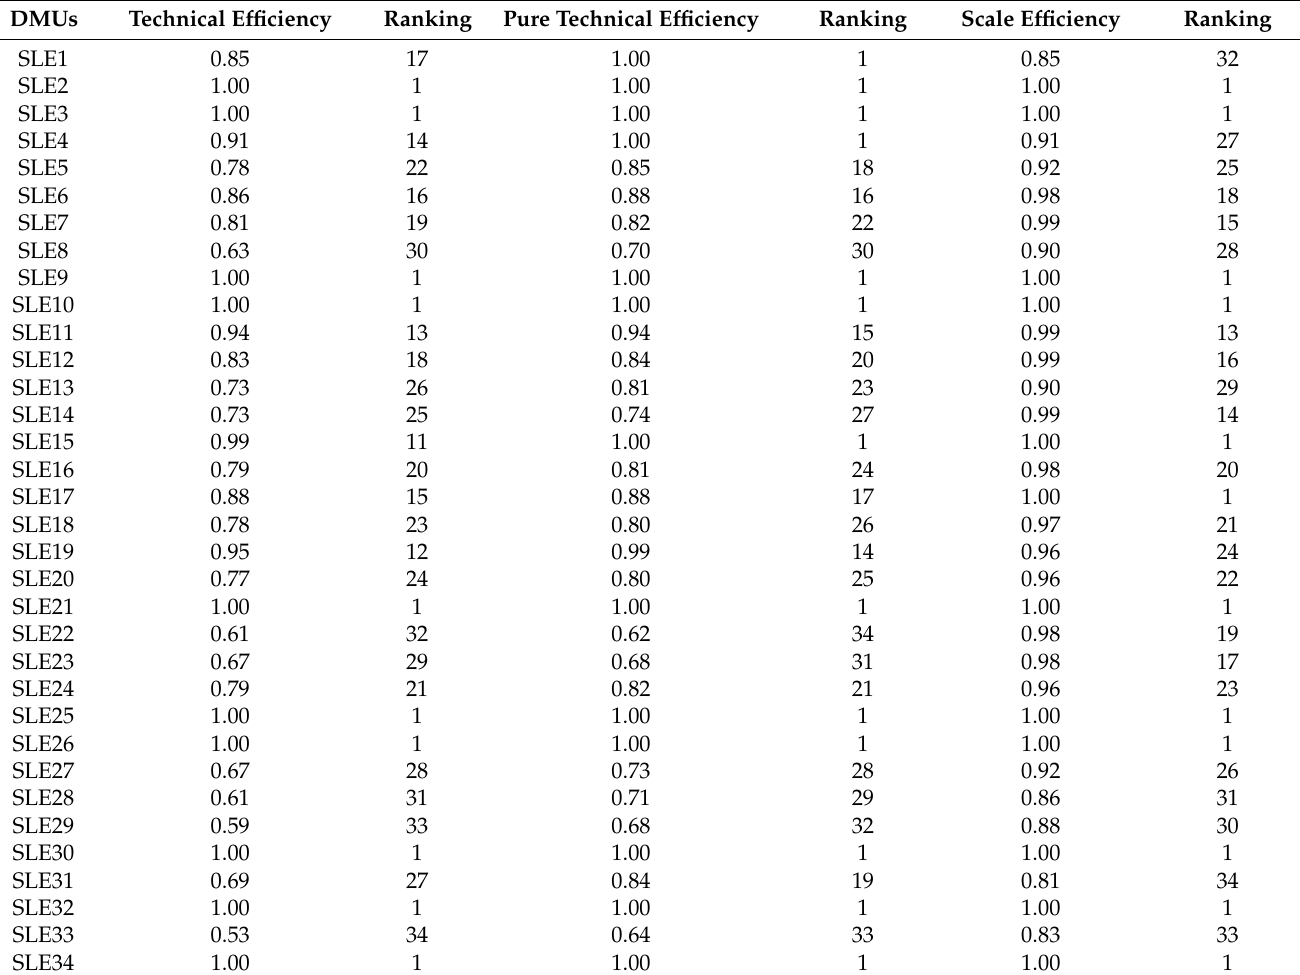
Table A5. Technical efficiency, pure technical efficiency, and scale efficiency for 34 listed LED energy enterprises in 2018. DMUs